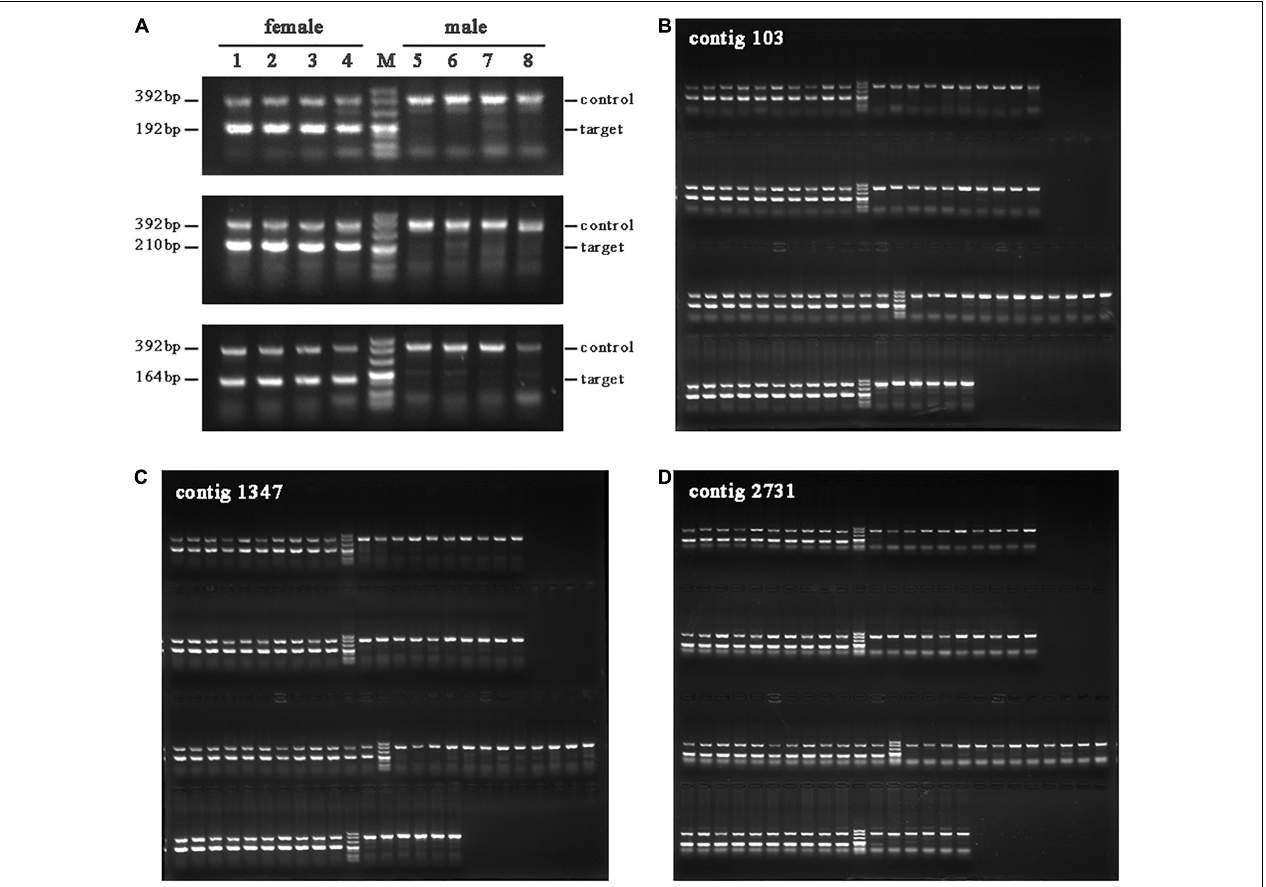
FIGURE 4 | PCR amplification of the female-specific sequences in female and male shrimps. (A) Female-specific sequence amplification with mixed DNA templates. Lanes 1–4 refer to females of “Huanghai No. 1,” “Huanghai No. 3,” wild shrimp bred for a generation, and captured wild shrimp, respectively; lanes 5–8 refer to male shrimps in the same order. The three lines from top to bottom correspond to three contigs (contig 103, contig 1347, and contig 2731). (B–D) The three contigs were amplified with individual DNA